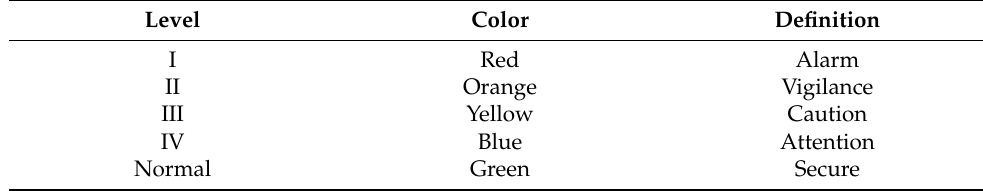
Table 2. Five-level warning